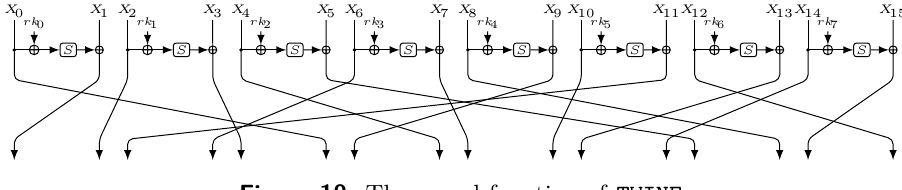
Figure 10: The round function of TWINE